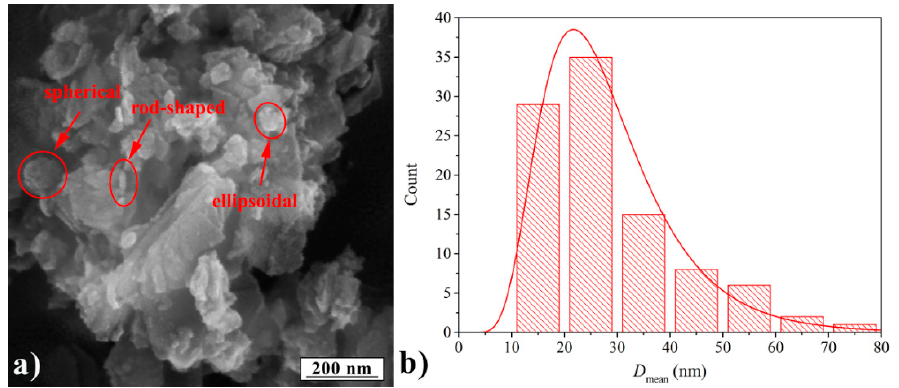
Figure 1. ( a ) FE-SEM micrograph of Mn-Al LDH filler and ( b ) lognormal diameter distribution. Table 3. The grain size distribution of Mn-Al LDH particles. Table 3. The grain size distribution of Mn-Al LDH particles. Mean